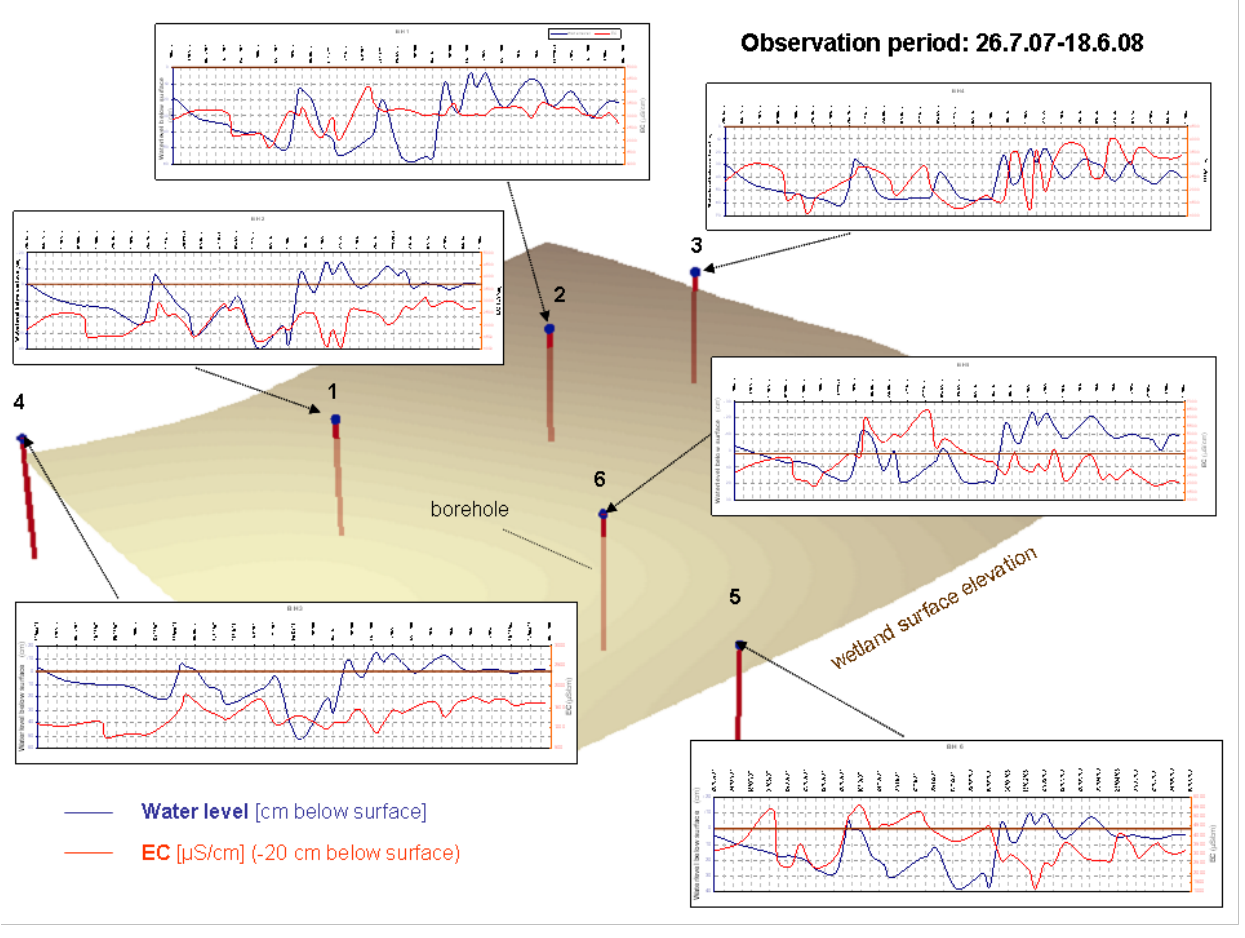
Figure 15. Spatial and temporal variation of the water level and electrical conductivity of near surface alluvial groundwater as measured at weekly intervals in boreholes of the transect at portion 7 during July 2007 and June